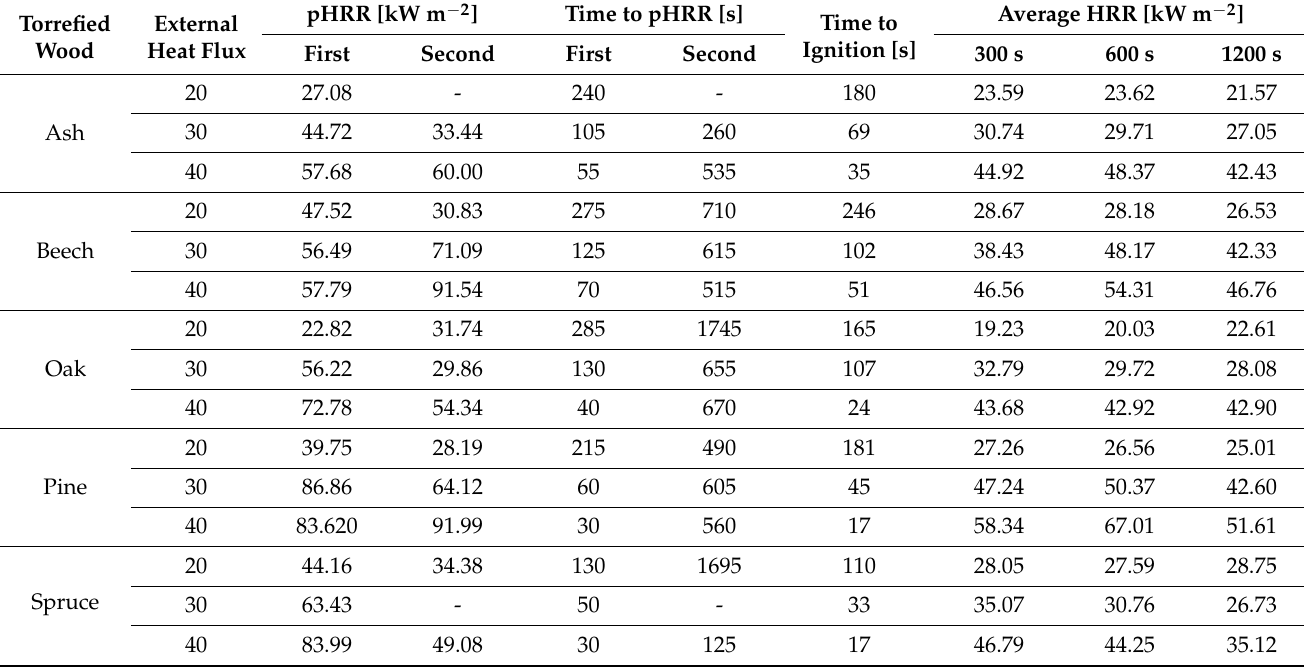
Figure 3. Phases of thermal degradation of torrefied wood: 1—pre-initiation phase, 2—initiation phase, 3—even combustion phase, 4—sample overheat phase, 5—low combustion phase, 6—heterogeneous combustion phase. Table 4. Cone calorimeter